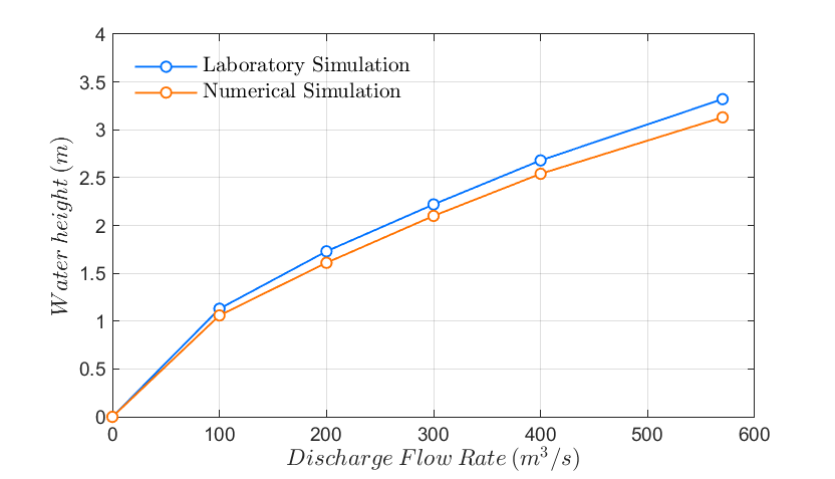
Figure 6. Comparison of predicted water level with measurements at the spillway